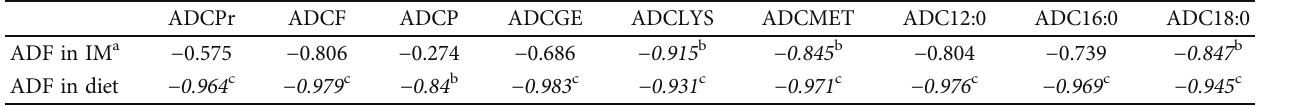
Table 5: Pearson correlation coe ffi cients between ADCs of insect meal ingredients and ADF levels in the tested insect meals and